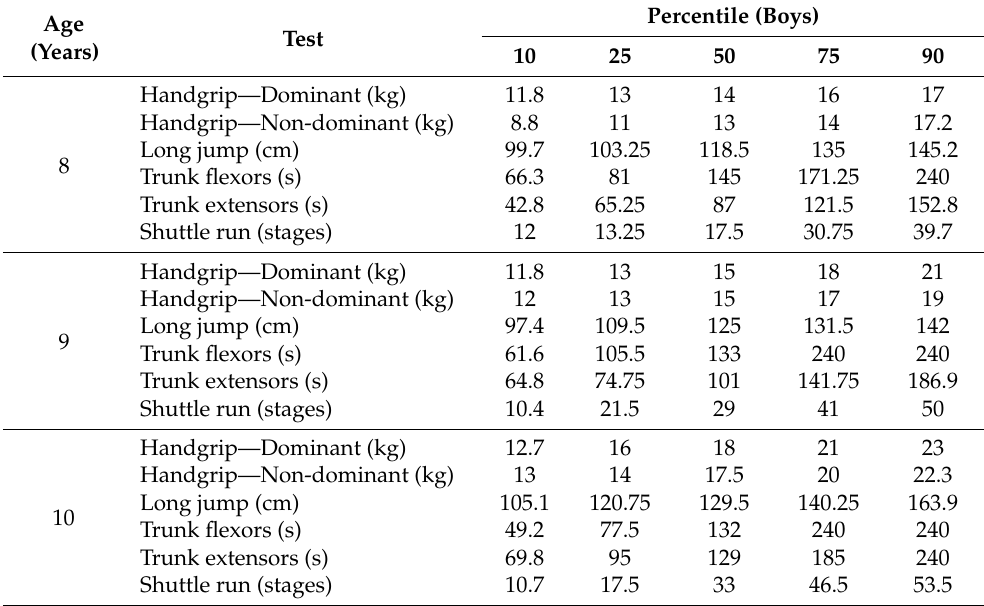
Table 4. Physical performance percentiles for boys (n =